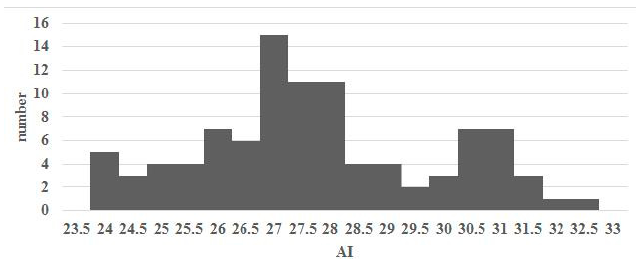
Figure 11. AI distribution for the 99 test data.